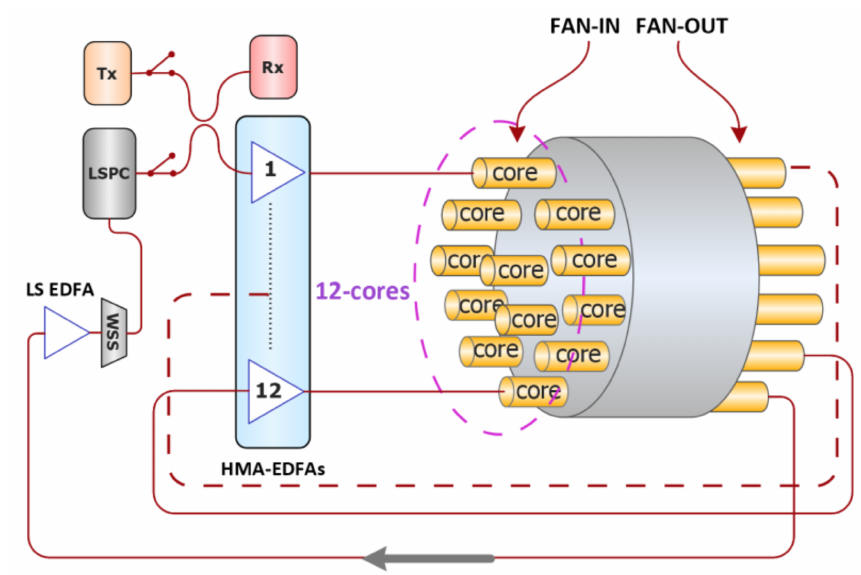
Figure 25. Schematic structure of a transmission test bed based on 12-core fiber and hybrid microassembly-based amplifiers with fan in–out devices, wavelength selective switch (WSS), and a loop synchronous polarization controller (LSPC) [66].